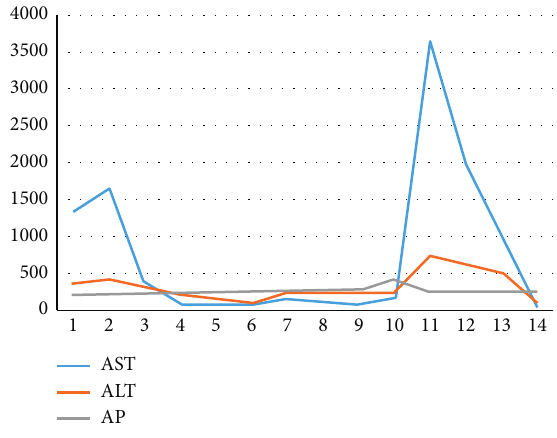
Figure 1: Liver enzymes